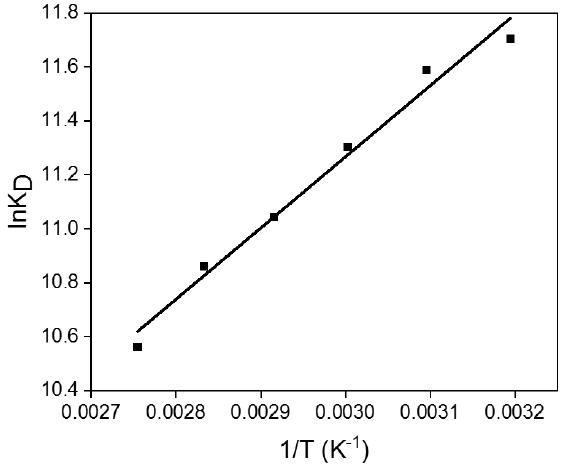
Figure 6. The plot of lnKD versus 1/T for estimation of thermodynamic parameters for MY sorption on CPSMNPs.